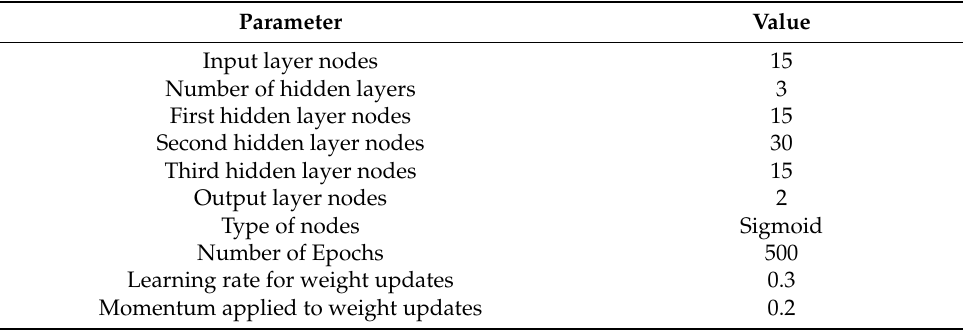
Table 2. Experimental Neural Network parameters.